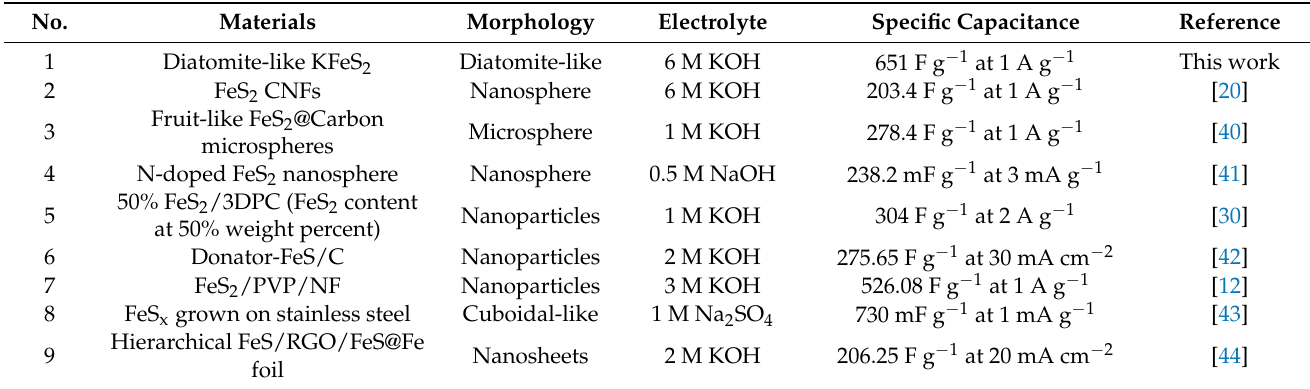
Table 1. Various iron-based sulfide electrode materials with their specific